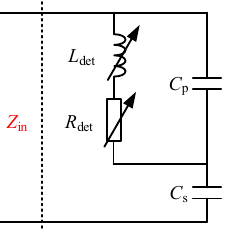
Figure 9. PS mixed resonance to amplify inductance variation.